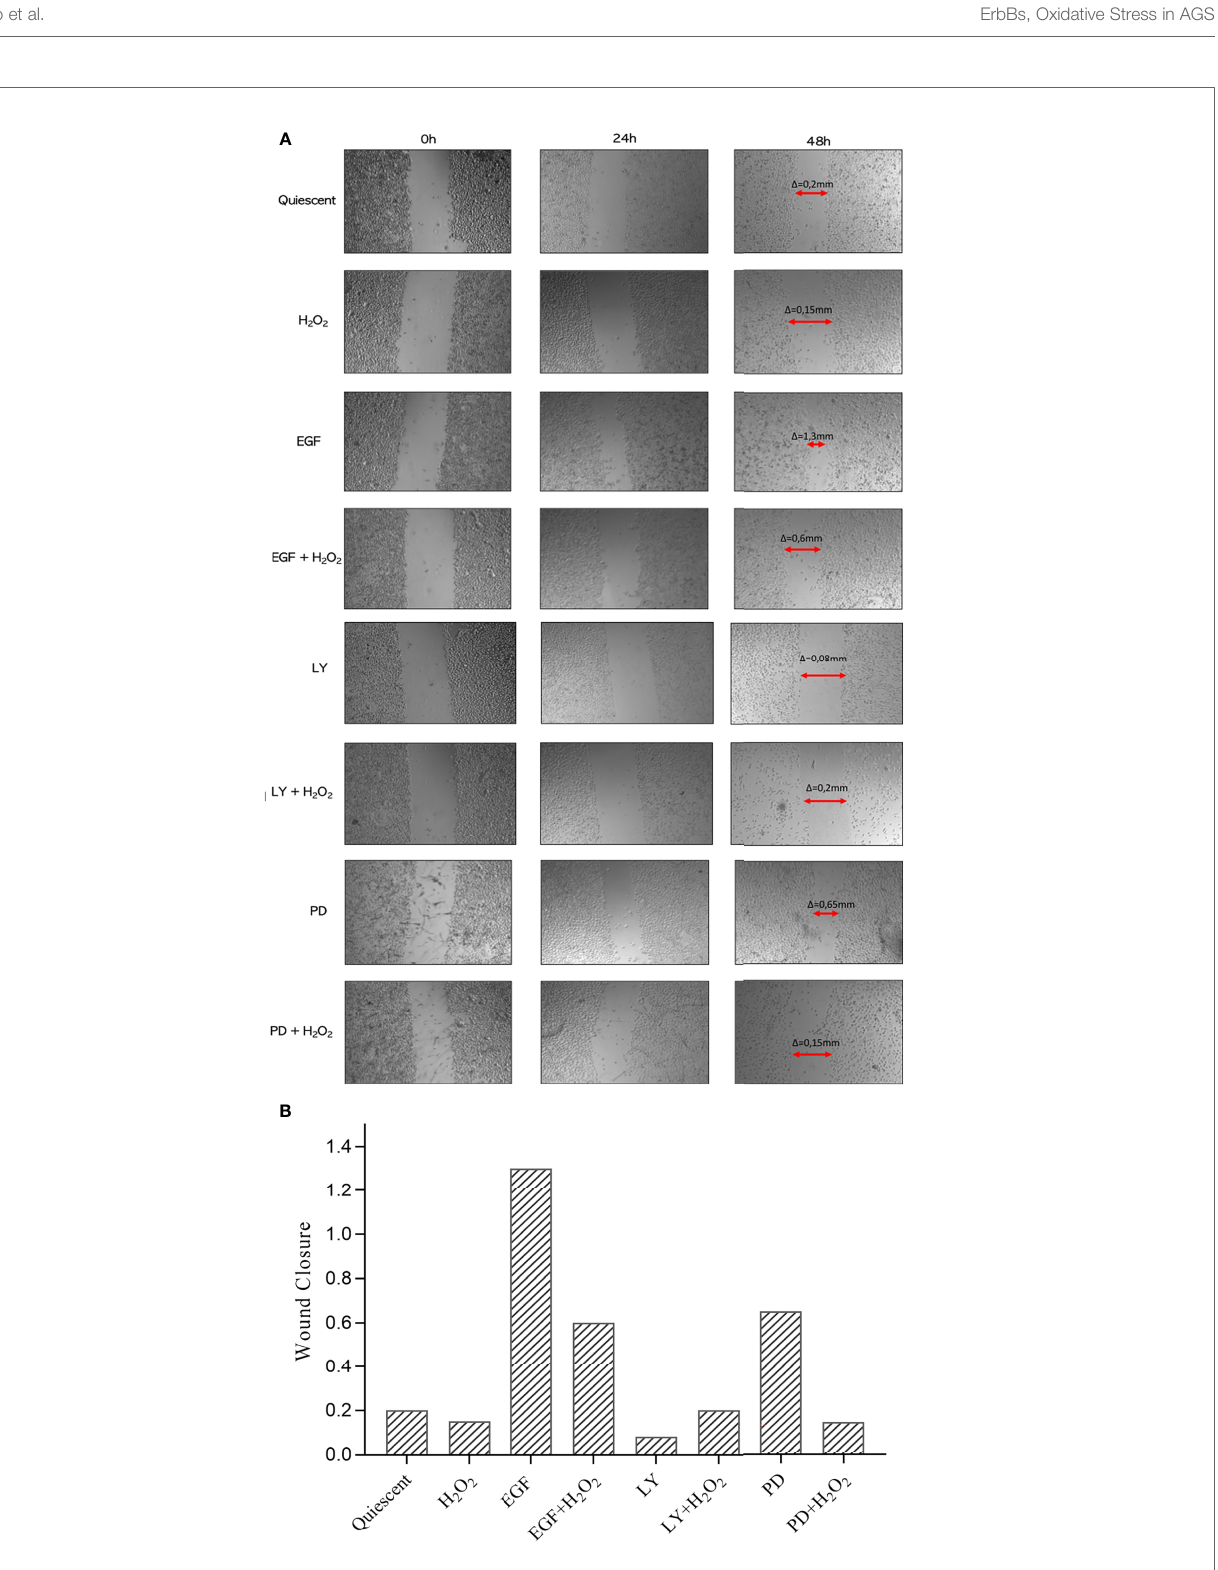
FIGURE 3 | (Effect of treatments on migratory behavior of AGS cells. (A) Wound Healing assay was performed in con fl uent monolayers and the area colonised by the cells estimated after untreated (Quiescent) and treated with 50 ng/mL EGF, 25 m M LY294002 (LY), 50 m M PD98059 (PD), and/or 50 m M H 2 O 2 , at time 0 and after 24 h and 48 h Arrows, closure of wound compared to time 0 ( D = gap width at 48 h minus that at time 0). (B) Percentages of wound clousure at 48 h under each conditions as in (A) are plotted. Representative of four independent experiments. PD: PD98059; LY: